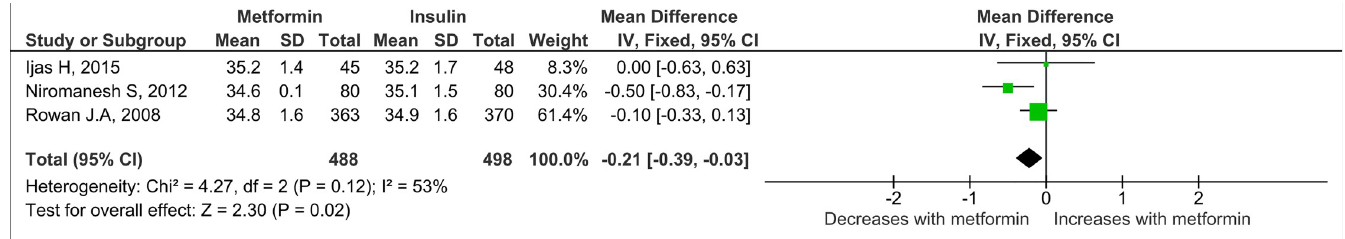
Fig 9. Neonatal head circumference. Expressed as mean difference (fixed effects model) and 95% CI. IV, mean difference.